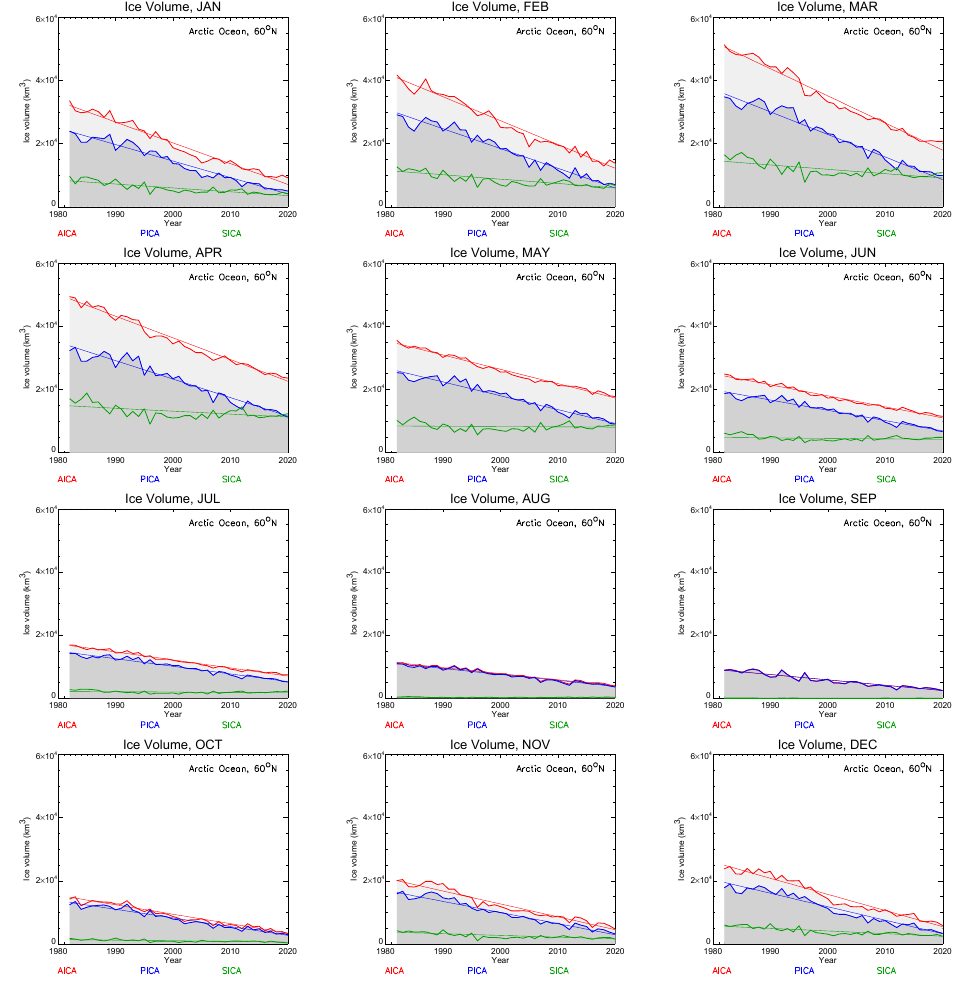
Figure 13. Arctic SIV time series for the Arctic area north of 60 ◦ N over 1982–2020 for the months of January through December. PICA (blue) stands for perennial ice-covered area, SICA (green) denotes seasonal ice-covered area, and AICA (red) designates all ice (PICA + SICA) covered areas. Over 1982–2020, AICA SIV decreased to 20,679.0 km 3 in 2020 from 51,216.6 km 3 in 1982, resulting in a 60% decrease at a rate of − 859.2 km 3 per year in March. In September, AICA SIV declined to 2462.0 km 3 in 2020 from 8931.2 km 3 in 1982, resulting in a 72% decrease at a rate of − 170.2 km 3 per year. Based on an annual average, AICA SIV decreased by 17,284.8 km 3 , which is 63% of the 27,590.4 km 3 in 1982, resulting in 10,305.5 km 3 SIV in 2020. PICA SIV and SICA SIV declined to 5766.0 km 3 and 4522.8 km 3 in 2020 from 20,313.0 km 3 and 7271.0 km 3 in 1982, respectively. In addition, the ratios of PICA SIV and SICA SIV to AICA SIV were declining in March, when Arctic sea ice reaches its maximum volume over 1982–2020 (Figure 14). It is around 2019 when the SICA SIV proportion started surpassing the PICA SIV proportion in March.